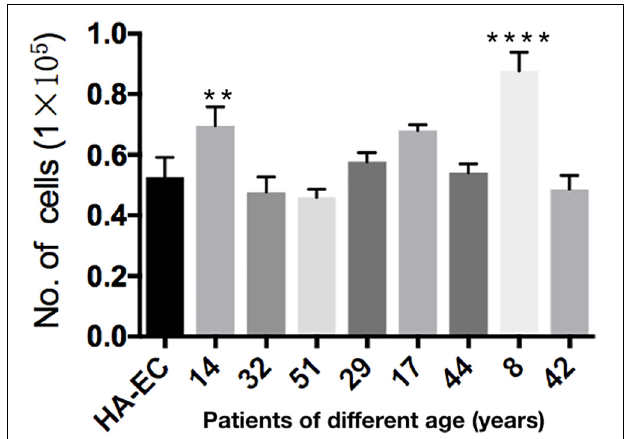
FIGURE 5 | Scratch assay in cAVM-ECs and HA-ECs. When HA-ECs and cAVM-ECs (derived from 8- and 14-year-old patients) were seeded in the 24-well plate, we detected the ability of migration among three groups at 6 and 12 h after seeding, respectively. (A–C) Scratch assay in HA-ECs, (A) 0 h after Scratched, (B) 6 h after Scratched, (C) 12 h after Scratched; (D–F) Scratch assay in cAVM-ECs (derived from 8-year-old patient), (D) 0 h after Scratched, (E) 6 h after Scratched, (F) 12 h after Scratched; (G–I) Scratch assay in cAVM-ECs (derived from 14-year-old patient), (G) 0 h after Scratched,